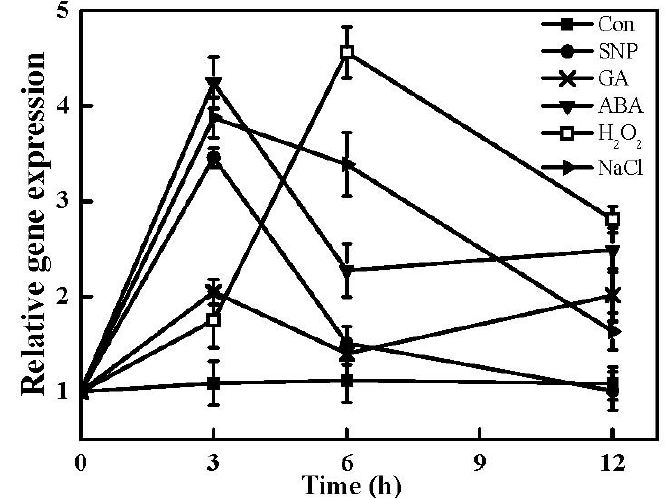
Figure 7. Induction of TaHO1 in response to SNP, GA, ABA, H Real-time RT-PCR was carried out from the total RNA isolated from the second leaves of wheat seedlings treated with 100 µ M SNP, 50 µ M GA, 100 µ M ABA, 100 µ M H 100 mM NaCl at the indicated time points. Relative expression levels of TaHO1 were presented relative to those of corresponding samples at 0 h,